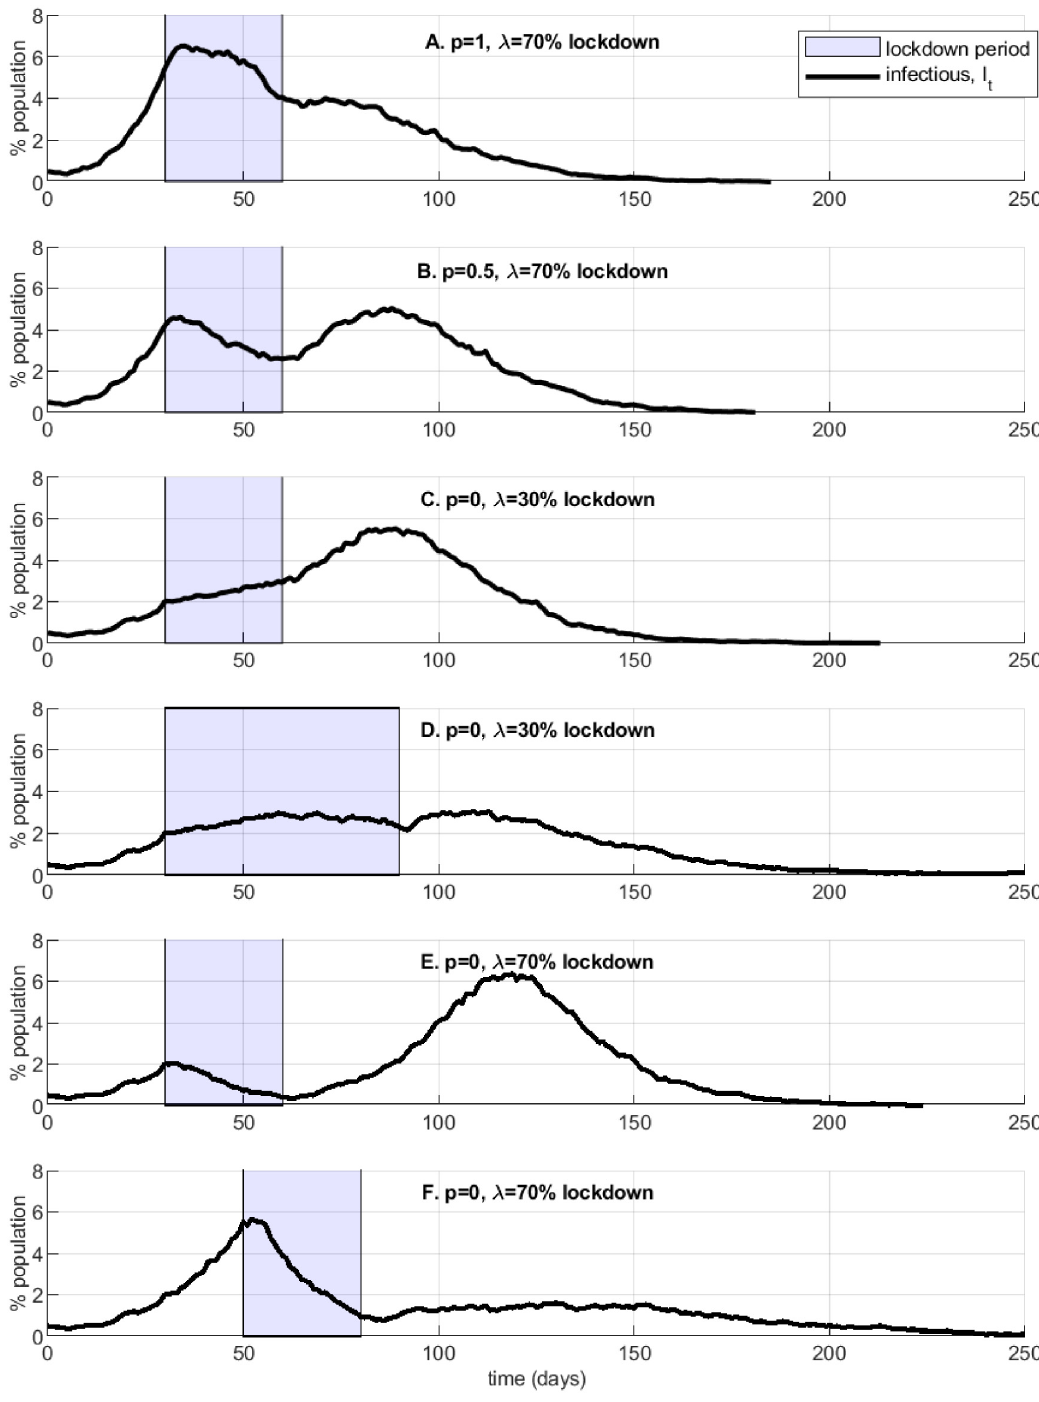
Fig 8. Lockdown success or